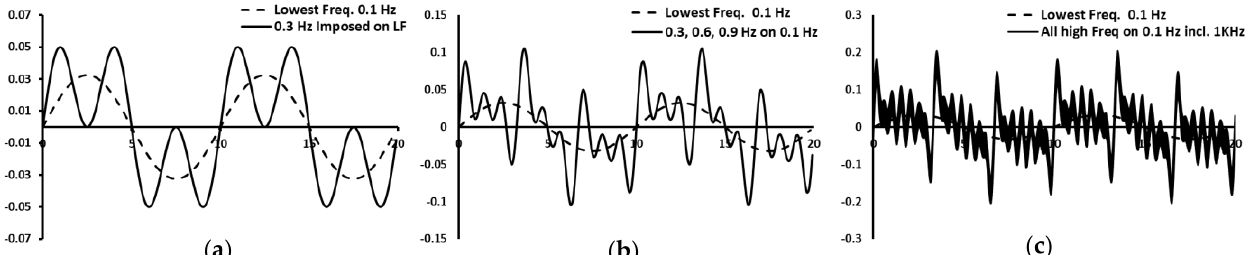
Figure 9. Combined multi-sine method. ( a ) Lowest frequency 0.1 Hz and 0.3 Hz imposed on 0.1 Hz ( b ) 0.3 Hz, 0.6 Hz, 0.9 Hz super imposed on 0.1 Hz. ( c ) All the frequencies including high frequency components superimposed on 0.1 Hz.